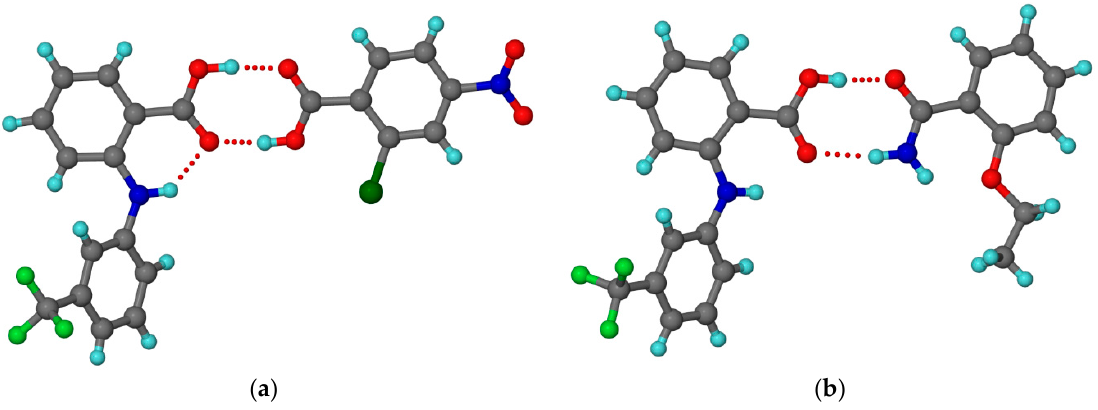
Figure 23. Acid-acid and acid-amide synthon observed in ( a ) FFA-CNB and ( b ) FFA-EA 1:1 cocrystals.